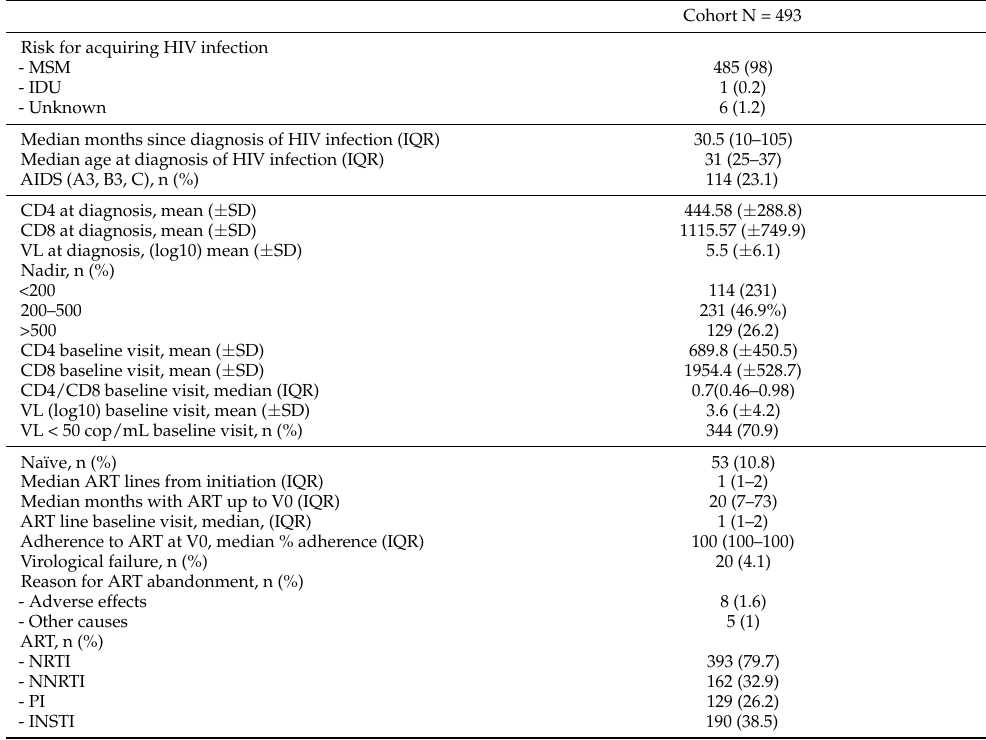
Table 2. Variables related to HIV